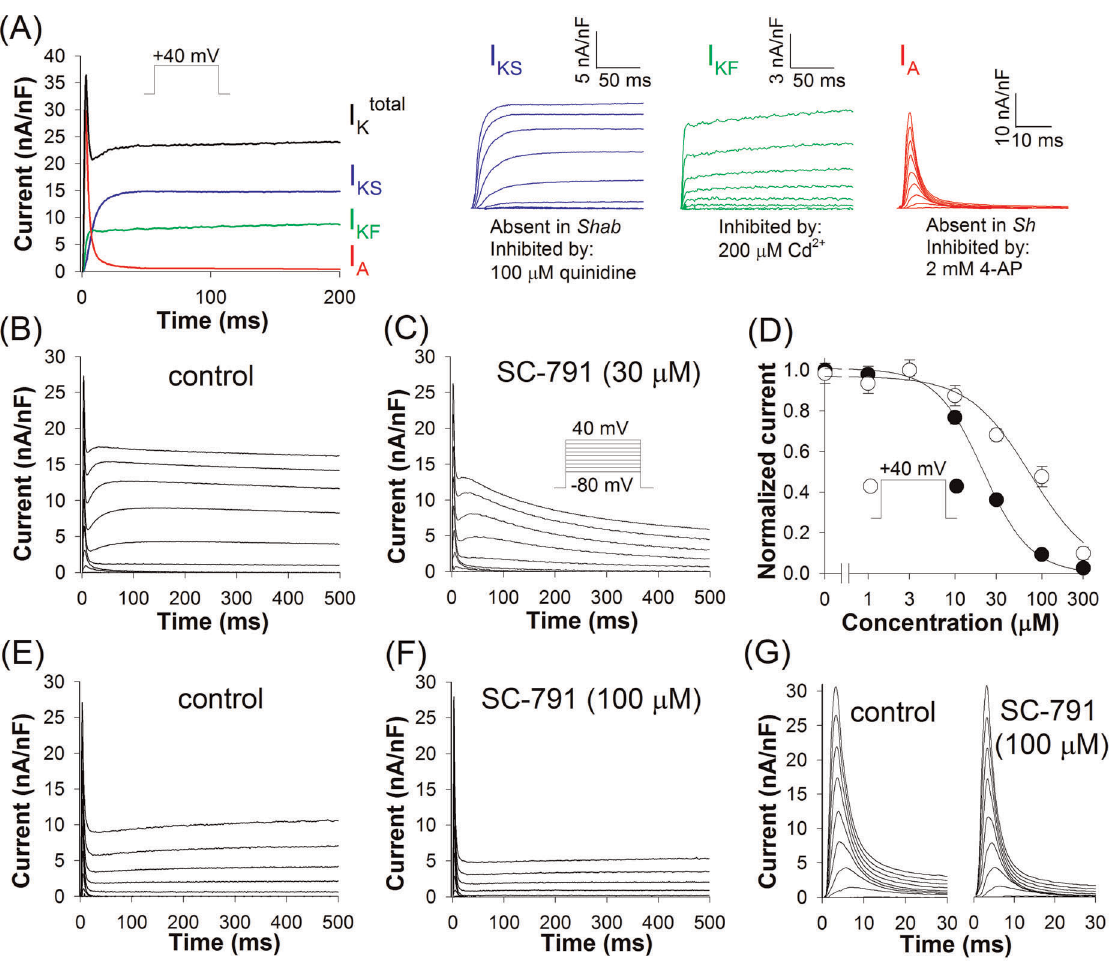
Figure 2. Inhibition of K + currents by SC-791. ( A ) Schematic representation of three voltage-activated K + currents. The average I KS in control ( B ) and in the presence of 30 m M SC-791 ( C ) in the wild-type larvae; currents were evoked by 500 ms voltage pulses between 2 40 and + 40 mV from a HP of 2 80 mV in 10 mV increments in the presence of 200 m M CdCl 2 in bath solution to block the I KF ; the I A can be seen in panels B, C, E, F in the beginning of each trace; it was not removed as it did not obscure the effects of SC-791 on other currents. ( D ) Dose-response relations for inhibition of the I KS by SC-791 at 50 ms after the onset (open circles) and at the end of a voltage pulse to + 40 mV (closed circles); the number of experiments varied from 5 to 12. The average I KF in control ( E ) and in the presence of 100 m M SC-791( F ) in Shab mutant larvae; the currents were elicited by 500 ms voltage pulses between 2 40 and + 40 mV from a HP of 2 80 mV in 10 mV increments; the number of experiments for each condition was 8. ( G ) SC- 791 did not affect the I A ; the currents were recorded from Shab larvae as in the panels ( B–C ) in the presence of 200 m M CdCl 2 to block the I KF ; the number of experiments for each condition was 9.